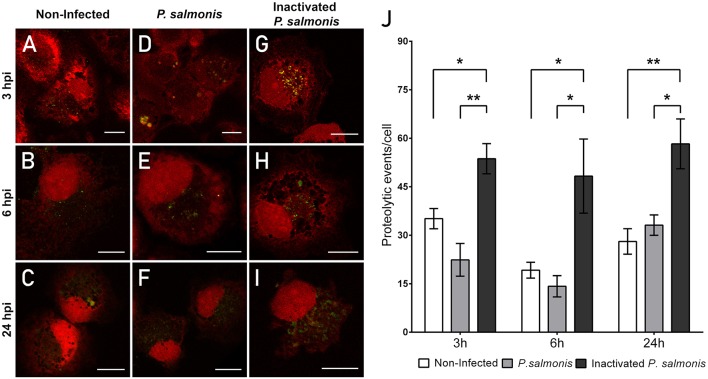
Lysosomal functionality in macrophage-enriched cell cultures infected with P. salmonis. Macrophage-enriched cell cultures were infected with P. salmonis at a MOI of 10 bacteria/cell and analyzed at 3, 6, and 24 hpi. Cells were treated with the DQ-BSATM Green probe to stain the proteolytic focusses; the nucleus was stained with PI (red). Non-infected macrophage-enriched cell culture and incubation with inactivated P. salmonis were used as controls for each time point. (A–C) Non-infected macrophages analyzed at 3, 6, and 24 h. Macrophage-enriched cell culture incubated with P. salmonis for 3 h (D), 6 h (E), and 24 h (F). Macrophage-enriched cell culture incubated with inactivated P. salmonis for 3 h (G), 6 h (H), and 24 h (I). Scale bar: 10 μm. (J) Quantification of proteolytic events in macrophage-enriched cell cultures infected with P. salmonis. Macrophage-enriched cell cultures were infected with P. salmonis at a MOI of 10 bacteria/cell and analyzed at 3, 6, and 24 hpi. The proteolytic events were detected using the DQ-BSA Green probe and data were quantified and normalized to the number of cells analyzed for each condition. Non-infected macrophage-enriched cell culture and incubation with inactivated P. salmonis were used as controls for each time point. The statistical analysis was performed through a parametric ANOVA with a Dunnett's multiple comparison test. Significant differences: *p <0.05, **p < 0.01.